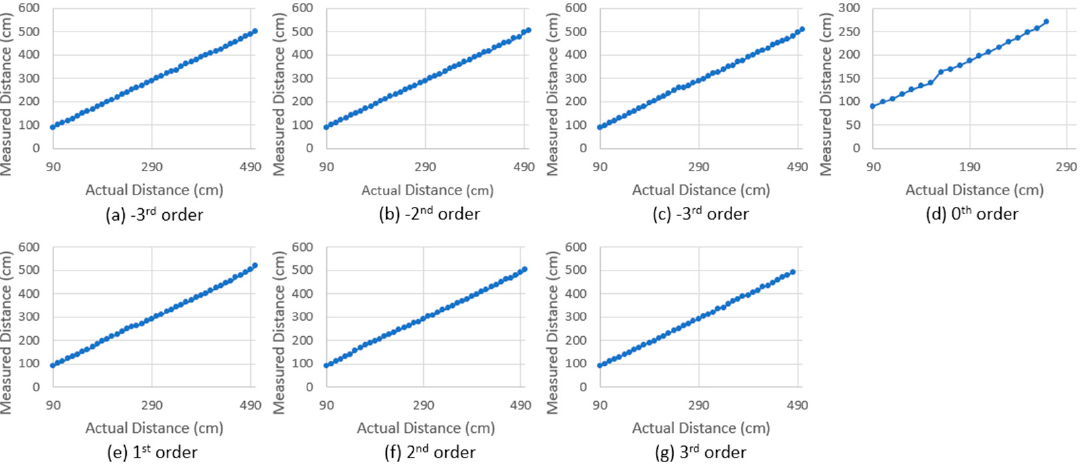
Figure 9. Measured distance vs actual distance for ( a ) − 3rd, ( b ) − 2nd, ( c ) − 1st, ( d ) 0th, ( e ) +1st, ( f ) +2nd, and ( g ) +3rd orders (seven diffraction orders). The measurements show good and consistent linearity across the seven sub-FOVs, corresponding to the − 3 to +3 diffraction orders of the Tx- and Rx-DMDs.